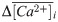
MCU upregulation promotes Ca2+ alternans through Ca2+- dependent opening of mPTP.Dependence of Ca2+ alternan amplitude Δ[Ca2+]¯i on αMCU and αmPTP. Δ[Ca2+]¯i is calculated as the difference between the last two Ca2+ transient peaks in a simulation of 30 sec. PCL = 500 ms.